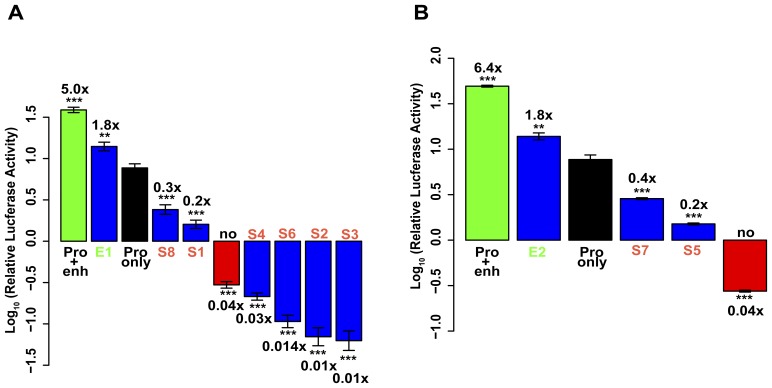
Regulatory activity of putative elements.(A) Mean activities of 8 replicates of Sau3AI-digested putative regulatory elements in C3A liver cells. Log10 changes relative to promoter-only construct shown. Error bars, standard error of the mean. (**, P<0.01 and ***, P<0.0001 compared to promoter-only construct, both figures.) (B) Mean activities of 8 replicates of AluI-digested putative regulatory elements in C3A liver cells.